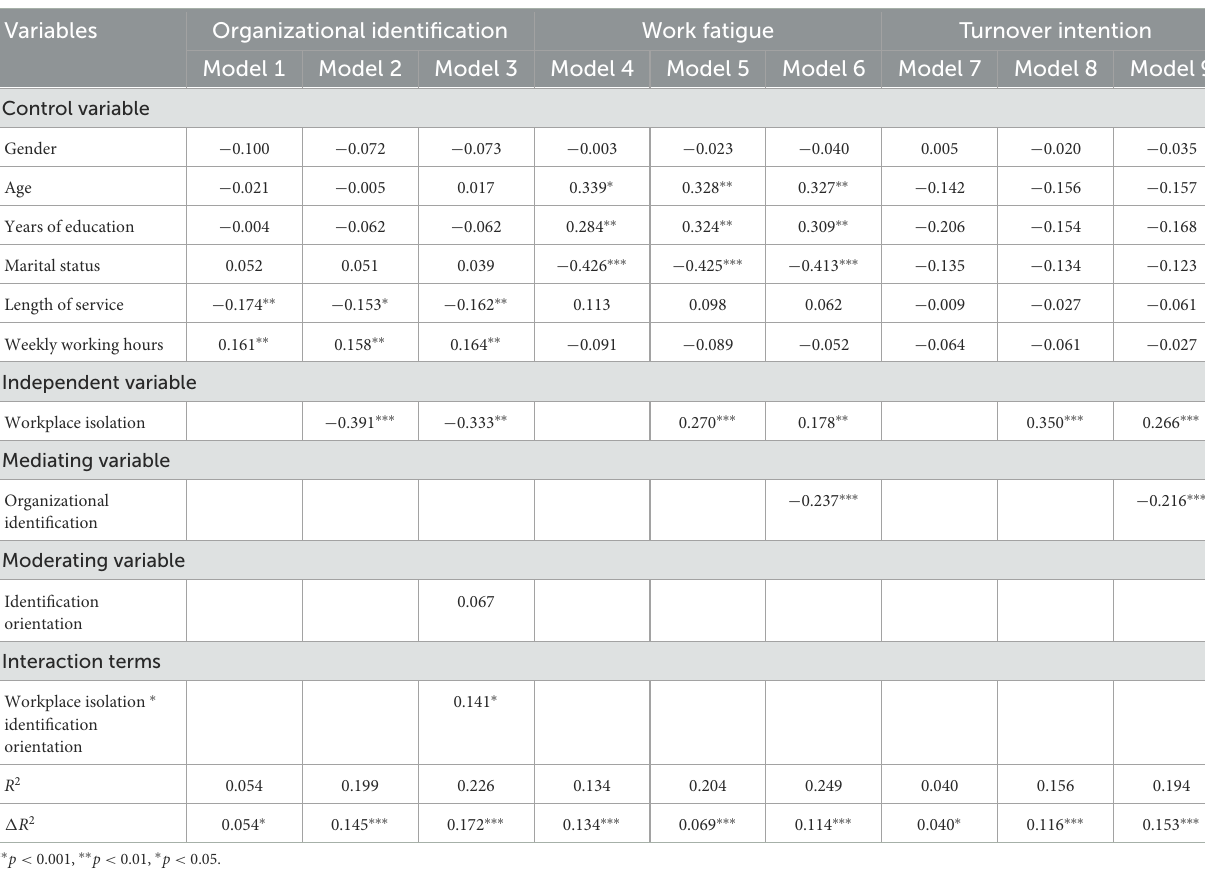
TABLE 4 Regression analysis model.